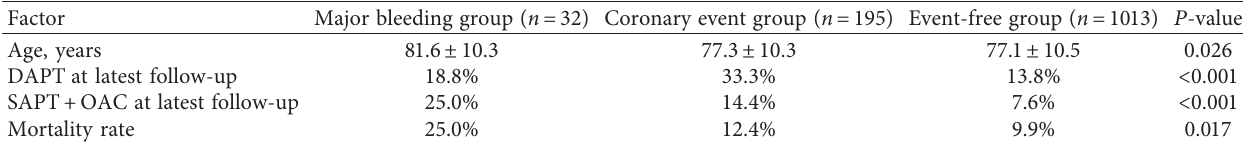
Table 4: Nonparametric test of the major bleeding, coronary event, and event-free groups.